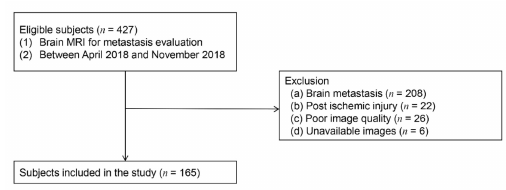
Figure 1. Participant selection